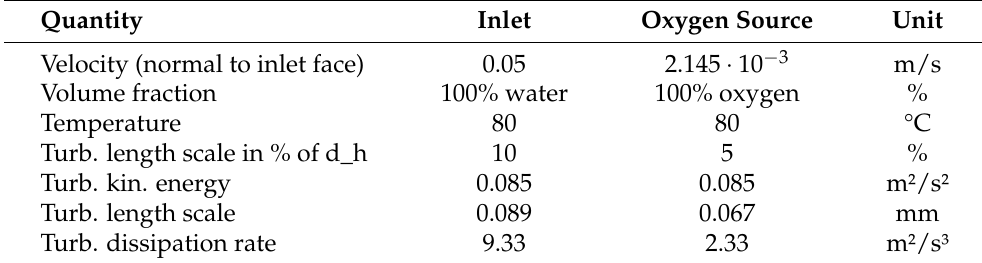
Figure 7. Boundary condition for the detailed volume-of-fluid model. Table 6. Boundary conditions for the detailed